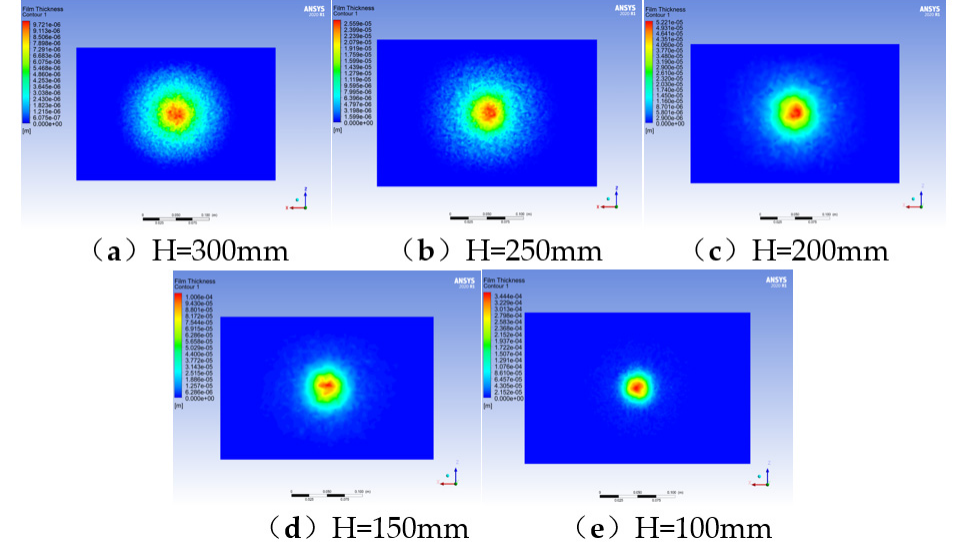
Figure 9. Film thickness distribution at different heights.